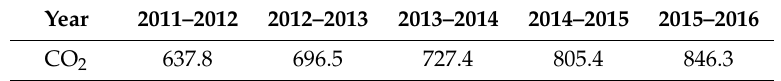
Table4. EmissionsofCO 2 (milliontonnes)forthepowersectorinIndiafrom2011–2012to2015–2016[10].